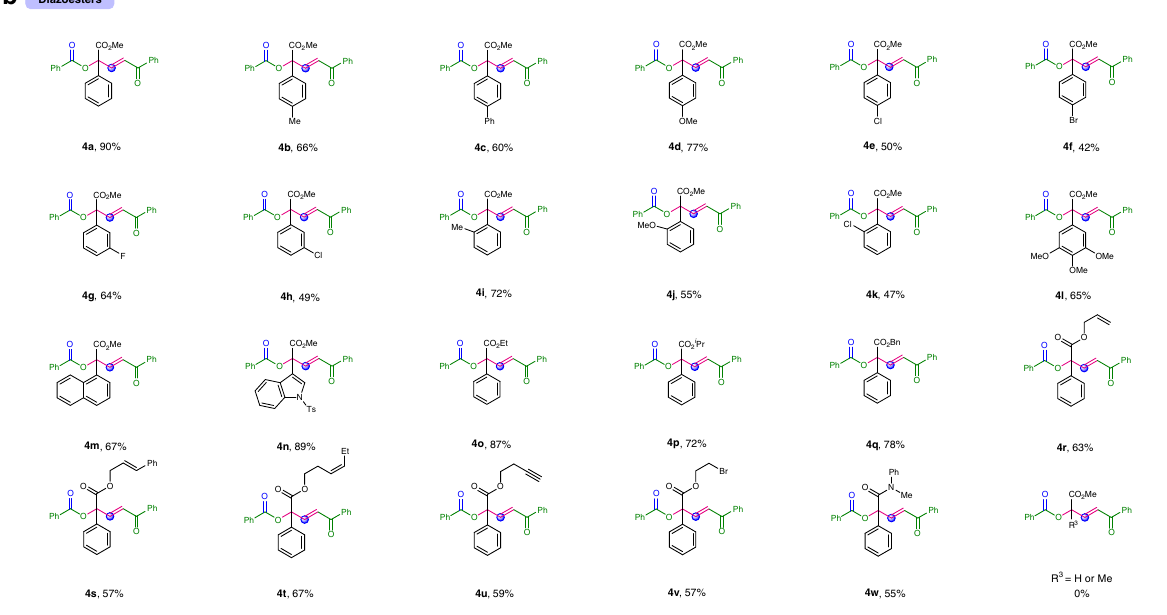
Fig. 2 Scope of substrates. a Scope of 1,3-diones. b Scope of diazoesters. Reaction conditions: 1 (0.2 mmol), 2 (0.1 mmol), Rh 2 (OAc) 4 (2 mol%), and 4 Å MS (50 mg), in DMF (0.5 mL) at room temperature under air atmosphere for 12 h. Isolated yields based on 2 are